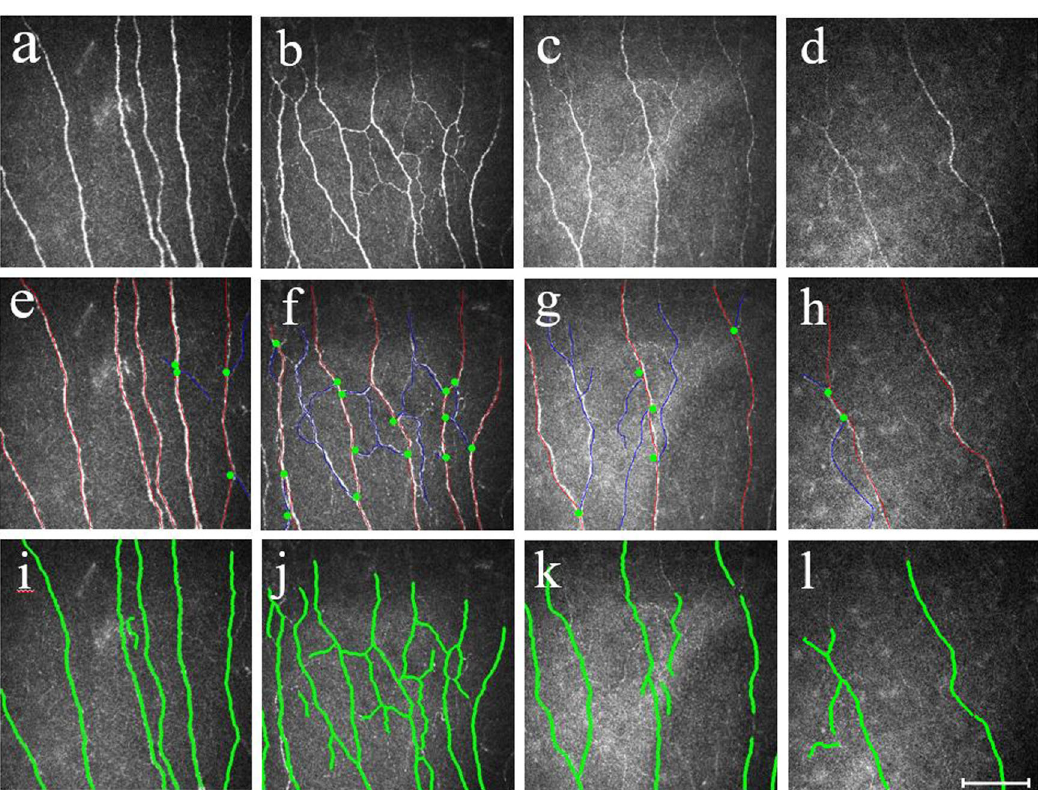
Fig. 2 Representative CCM images in healthy controls, AutD-N, AutD-S, and AutD-M. Corneal nerve fi bers are beaded, linear homogeneous and highly re fl ective ( a – d ). Nerve fi ber trunks are highlighted in red, green dots indicate the origin of the branches, and blue and red lines combined indicate the corneal nerve fi ber length ( e – h ). Pictures ( e – h ) were analyzed with the manual software (CCMetrics) and images ( i – l ) were marked with the automated version (ACCMetrics). CCM corneal confocal microscopy, PD Parkinson ’ s disease, AutD-N patients with no autonomic symptoms, AutD-S patients with single-domain autonomic symptoms, AutD-M patients with multiple-domain autonomic symptoms. Scale bar = 100